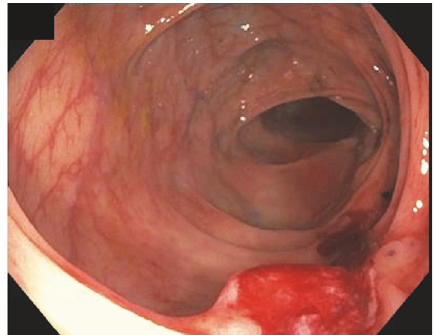
Figure 2: The nodule was partially removed by cold snare polypec- tomy but was not amenable to complete removal under